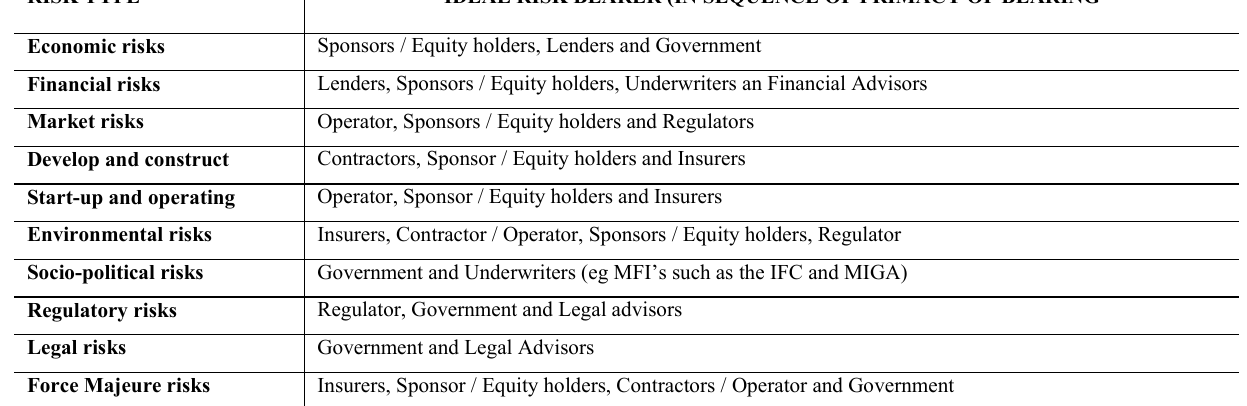
Table 3: Risk allocation matrix RISK TYPE IDEAL RISK BEARER (IN SEQUENCE OF PRIMACY OF BEARING Economic